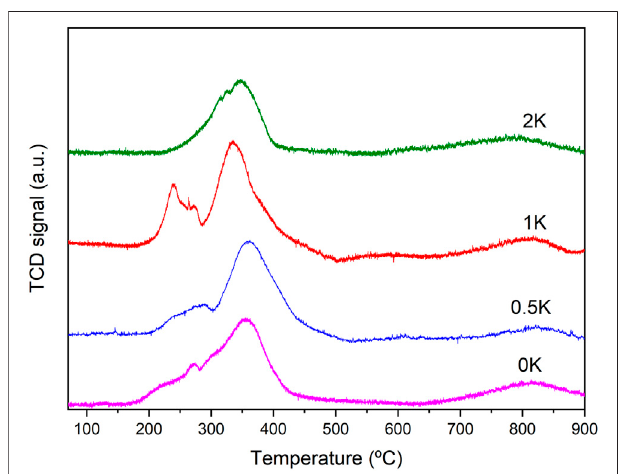
FIGURE 5 | H 2 -TPR pro fi les of the synthesised